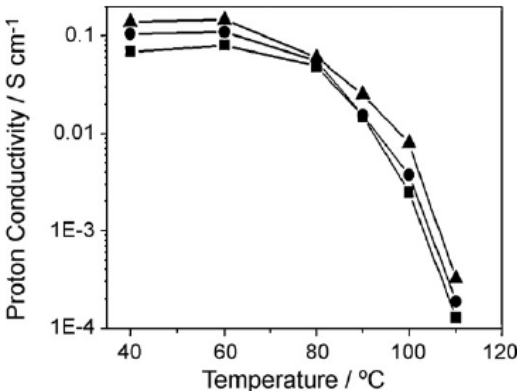
Figure 8. The proton conductivity of membranes without external humidification. Triangle is zirconia-doped, circle is silica-doped membrane and square is recast Nafion. Reprinted with permission from Ref. [48]. Copyright 2010 Elsevier.